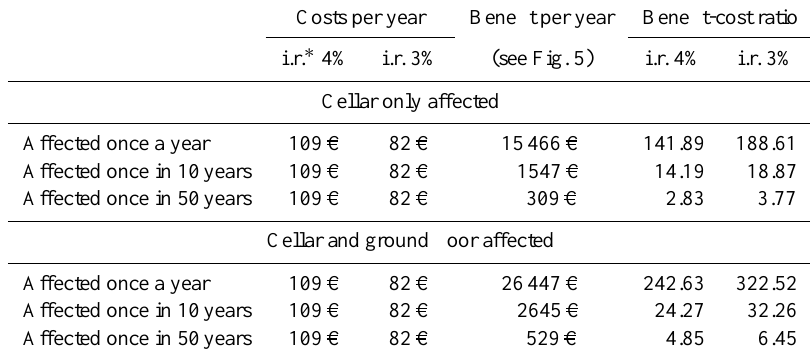
Table 6. Benefit-cost ratios for securing oil